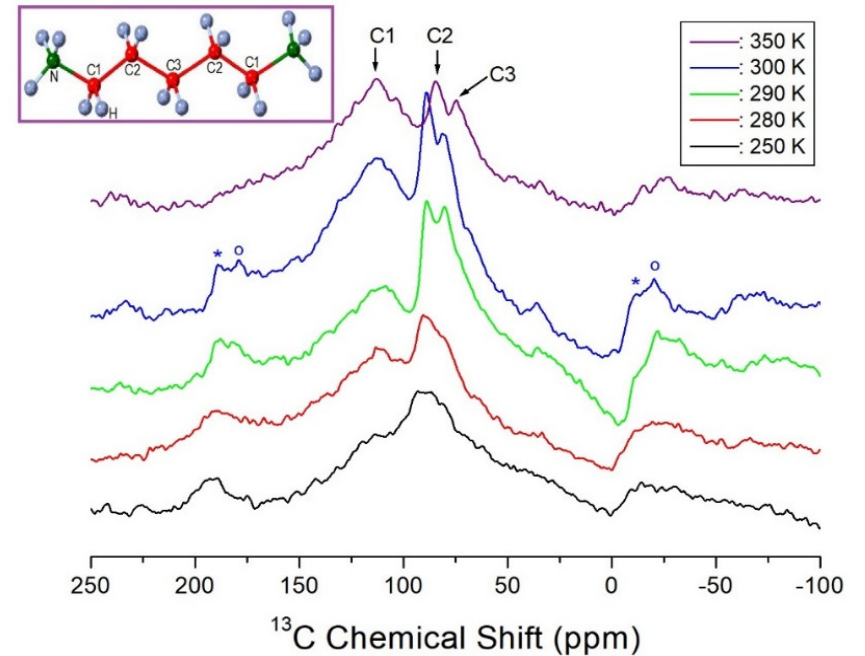
Figure 8. 13 C NMR chemical shifts of [NH 3 (CH 2 ) 5 NH 3 ]MnCl 4 at 250, 280, 290, 300, and 350 K. * and o are the spinning sidebands.